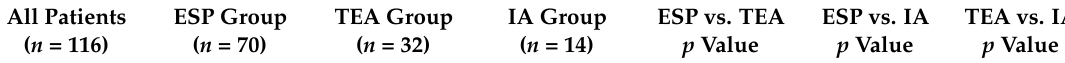
Table 2. Intraoperative anesthetic and surgical